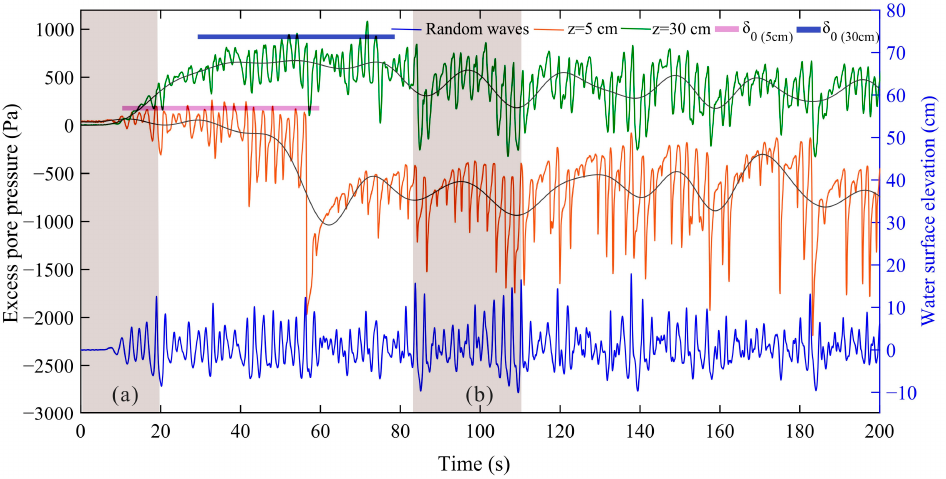
Figure 5. Excess pore pressure response for liquefied seabed impacted by random waves in Experiment IV-2 (detailed view): blue curve—random waves; orange curve—excess pore pressure response at 5 cm below the seabed; black curve—excess pore pressure response at 30 cm below the seabed; 𝜎 (cid:2868) —initial mean normal effective stress of the seabed.